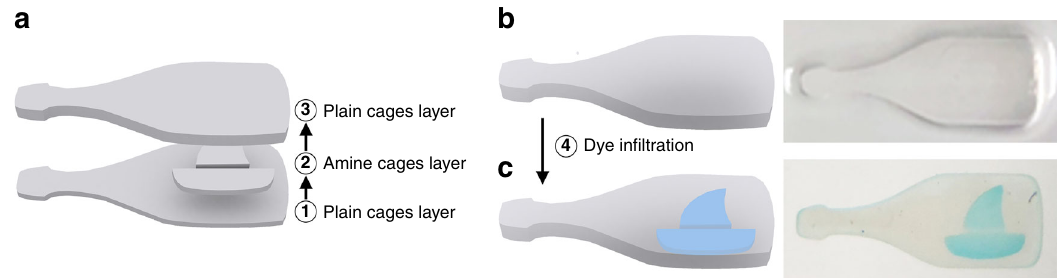
Fig. 5 Accessibility of functionalities within printed structures. A ship pattern made of amine and methacrylate-functionalized cages was printed between two layers of plain cages only functionalized with methacrylate ligands and forming a bottle shape ( a ). In the resulting part ( b ), the “ ship in a bottle ” is invisible. After immersion in a Cy5-NHS solution, however, the dye penetrates the structure and bind selectively to the amine groups, revealing the ship after additional washing ( c ).